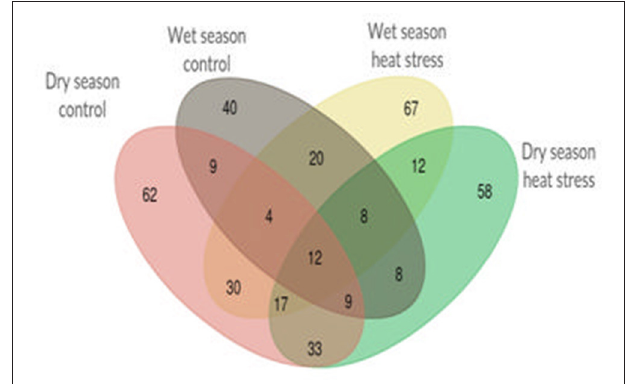
FIGURE 2 | Venn diagram showing total 613 unique and shared significant marker-trait associations among normal and heat stress conditions during wet season 2012 and dry season 2013.